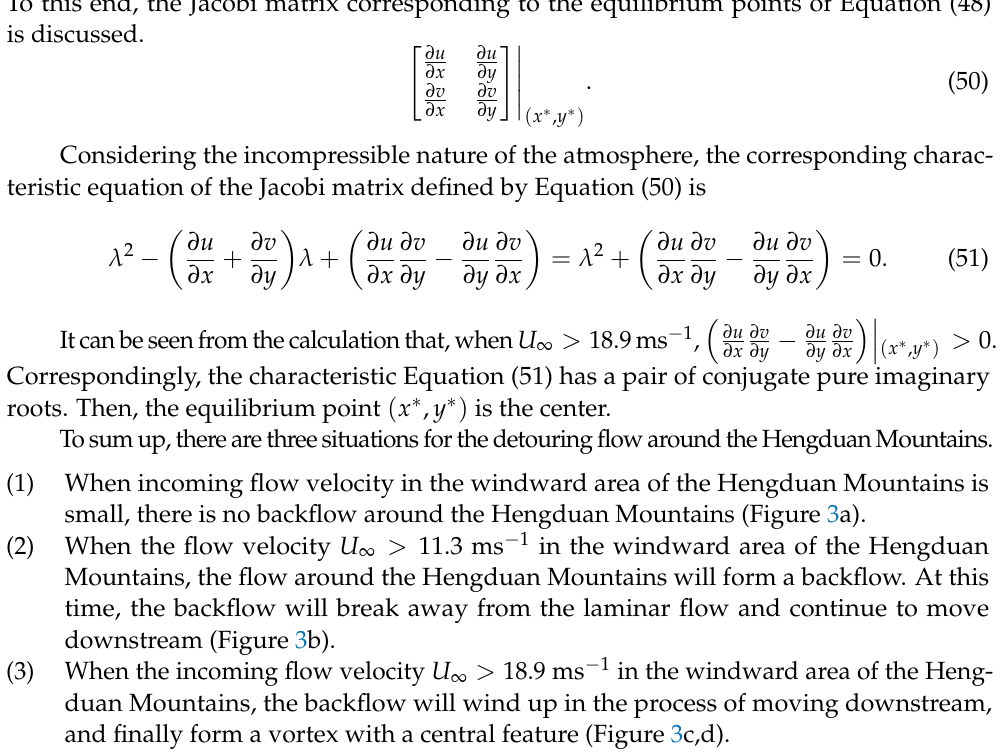
Figure 3 is a schematic diagram of the flow field in the curved coordinate system, which is offset by about 90 ◦ from the traditional longitude–latitude coordinate